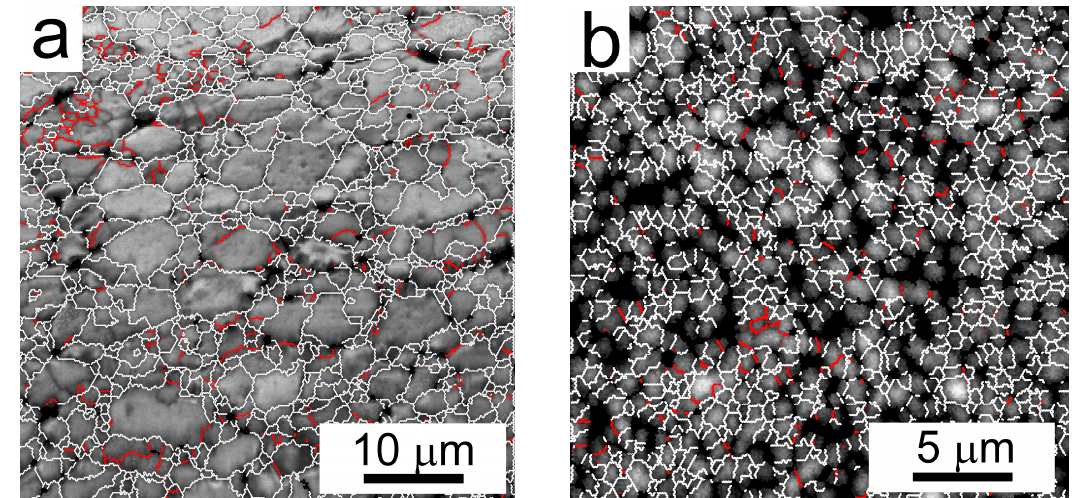
Figure 14. Distribution of grain boundaries corresponding to EBSD micrographs of Figure 12. Boundaries with misorientation angles above 15° in white and boundaries between 5° and 15° in red.